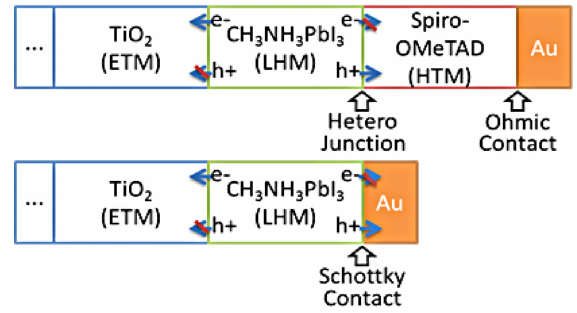
Fig. 1. Schematic representations of perovskite solar cells with (a) a hetero-junction or (b) a Schottky contact at hole collector side,